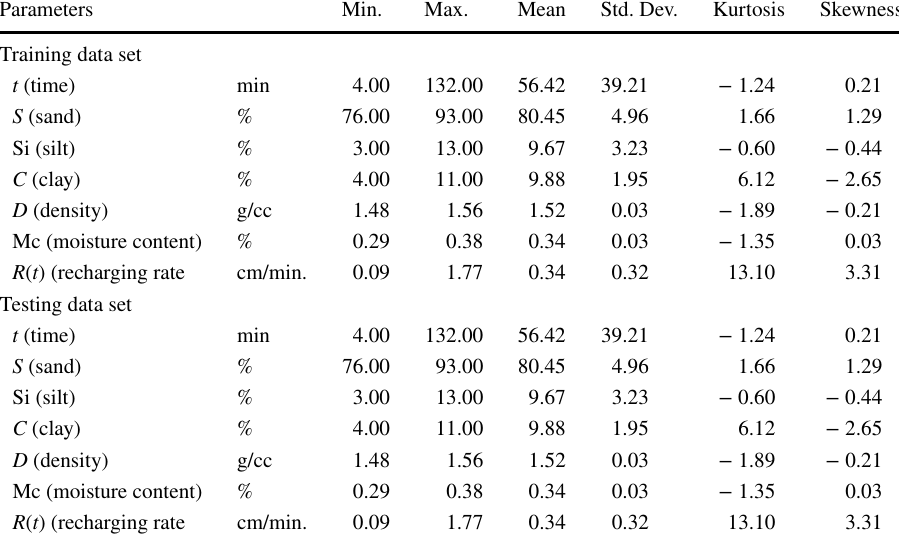
Table 1 Features of the data set